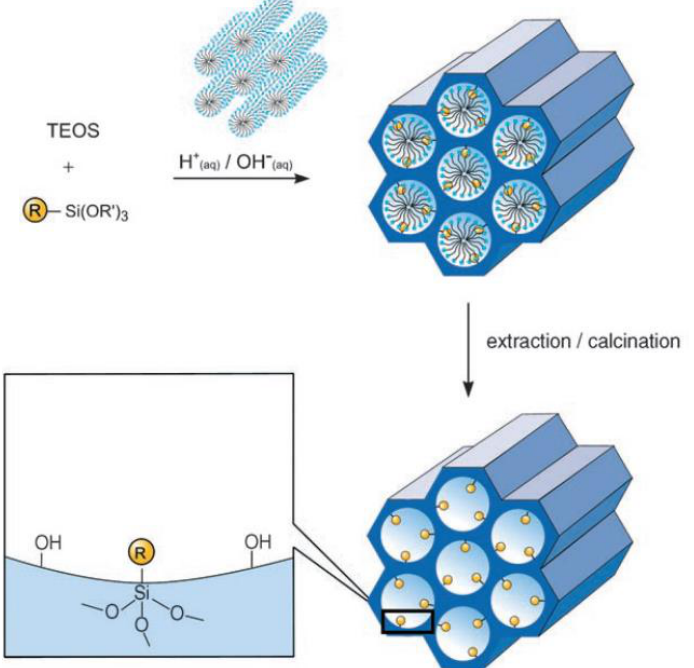
Figure 6. Co-condensation between tetraethyl ortosilicate (TEOS) and a generic silyl-derivative compound, RSi(OR’) 3 , followed by calcination/extraction to achieve hybrid organic-inorganic meso- porous silica [22]. Reprinted with permission from [22]. Copyright 2006, John Wiley and Sons. An additional tool to incorporate specific organic functionalities within silica-based materials are tethering procedures. For that, firstly, mono-silanes RSi(OR’) 3 are incorpo- rated into a silica support (either by co-condensation or grafting). Afterwards, in a post- synthetic step, an organocatalyst featuring the active site of interest and a specific func- tional group R* is reacted with the hybrid material. R and R* need to be chosen properly, so that they can react and form a covalent bond that can guarantee the anchoring of the organocatalyst. Example of such R/R* pairs include primary amine and isocyanate, react- ing to form urea group; thiol and terminal alkene, reacting in presence of a radical initiator